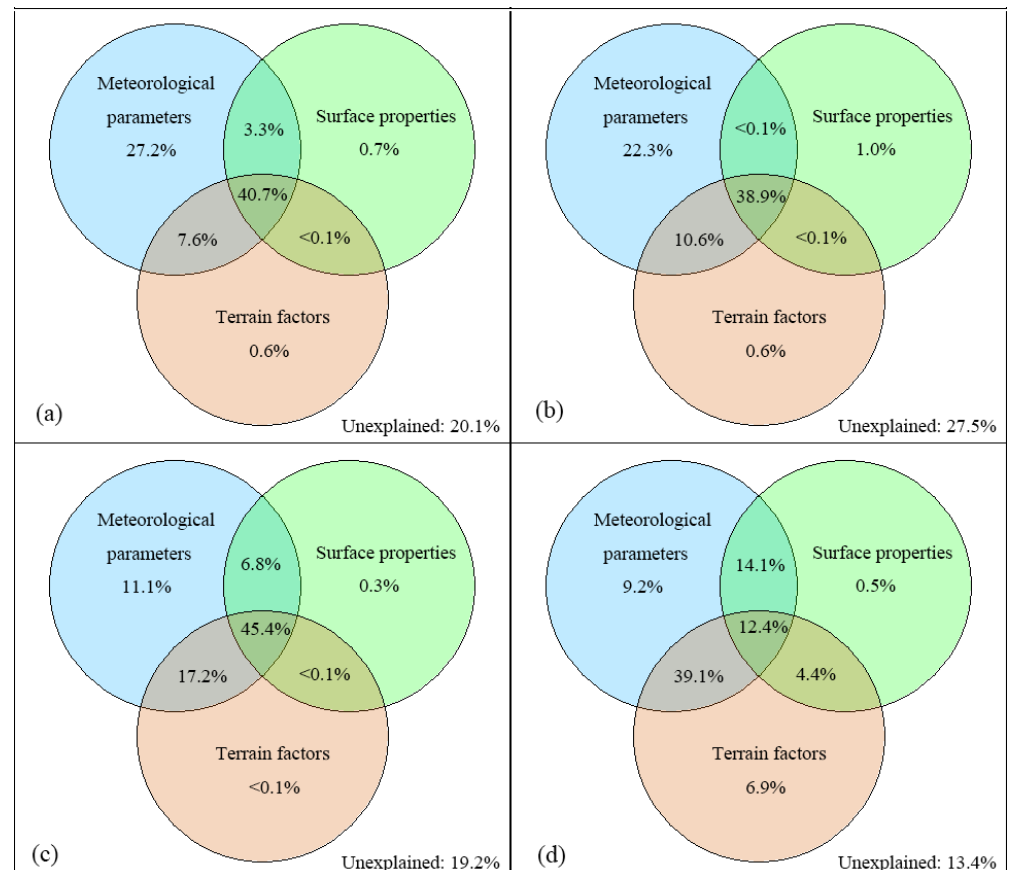
Figure 11. Seasonal variation partitioning and average AODs explained in the following seasons: (a) spring; (b) summer; (c) autumn; and (d) winter.